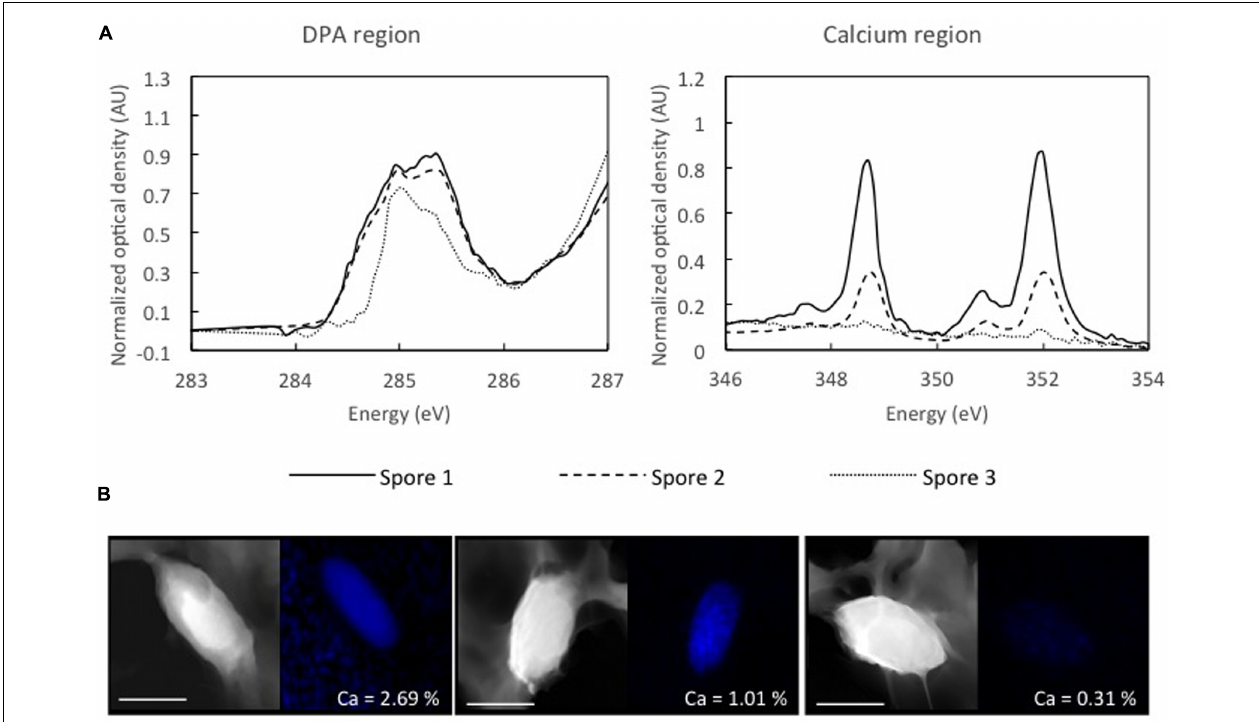
FIGURE 4 | Energy spectra for DPA and calcium regions in three different spores of C. beijerinckii DSM 791 obtained by STXM. (A) Spores were chosen based on differences in calcium and DPA content, spore with low DPA and low calcium (dotted line), spore with higher DPA and higher calcium (dashed line) and spore with high DPA and high calcium levels (black line). (B) STEM and EDS maps of the same three spores of C. beijerinckii DSM 791 obtained after STXM measurement. Atomic percentage of calcium is shown for each spore. Scale bar represents 1 µ